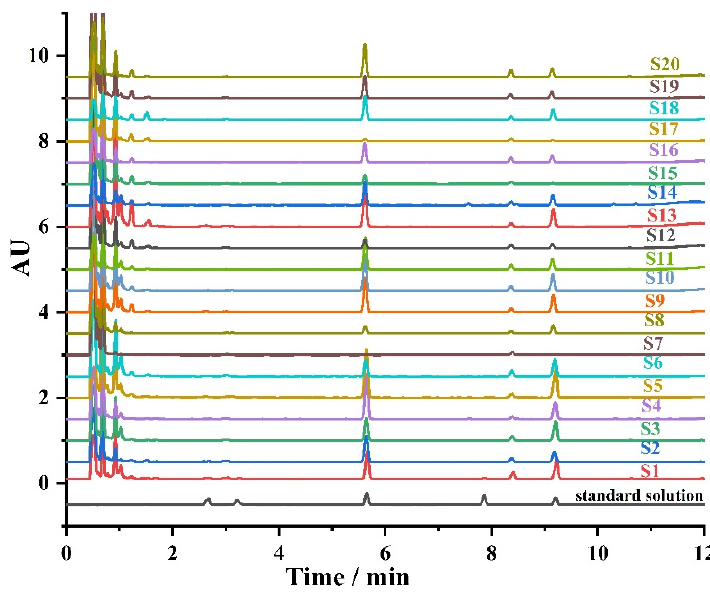
Figure 5. The chromatograms of the 20 Polygonum multiflorum samples. Table 5. The results of UHPLC-PDA analysis of 20 Polygonum multiflorum samples collected from different regions in China.